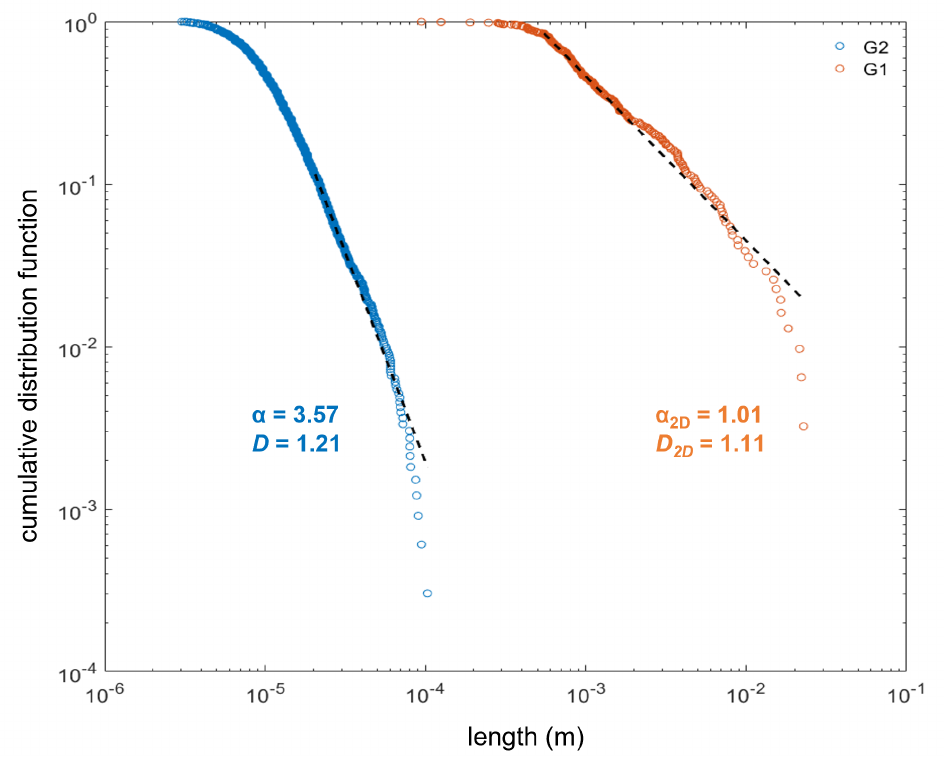
Figure 7. Segmented fracture networks and cumulative distribution function for shale rock microflu- idic device images corresponding to samples M1 and M2.